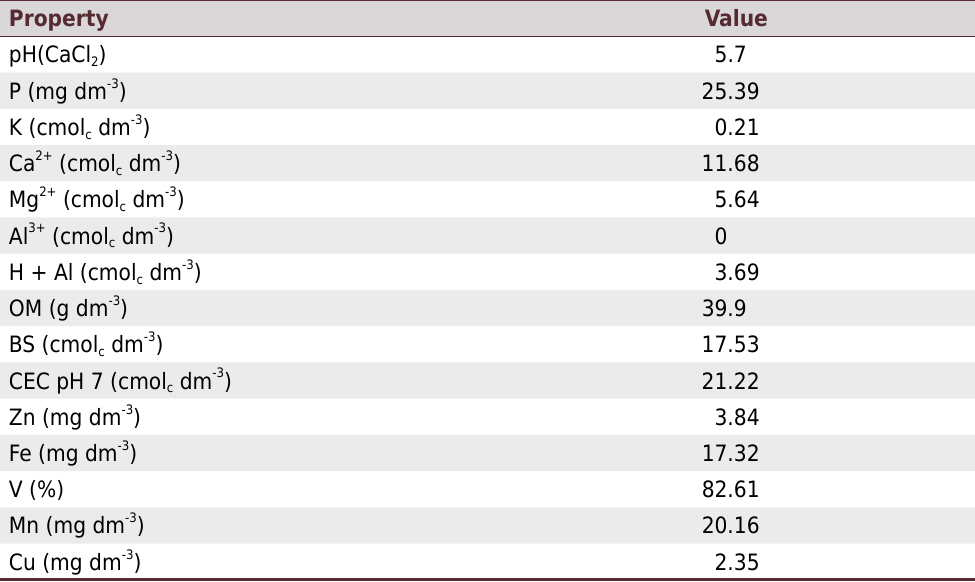
Table 1. Soil chemical properties of the experimental area